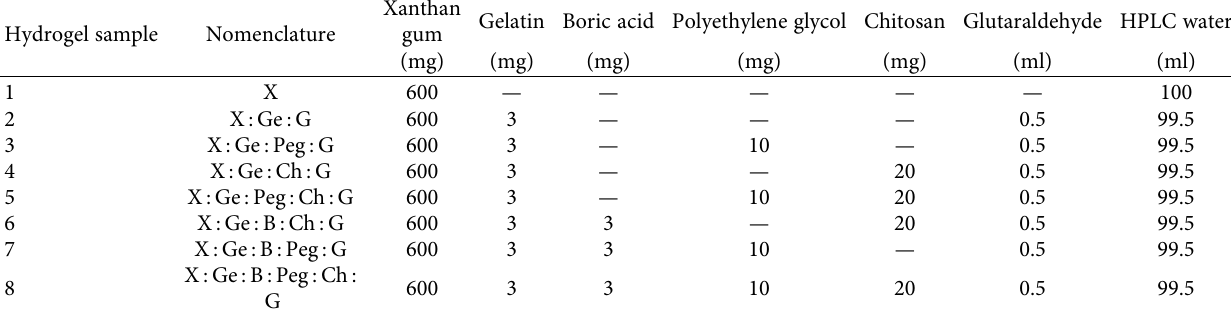
Table 1: An overview of hydrogel formulation.